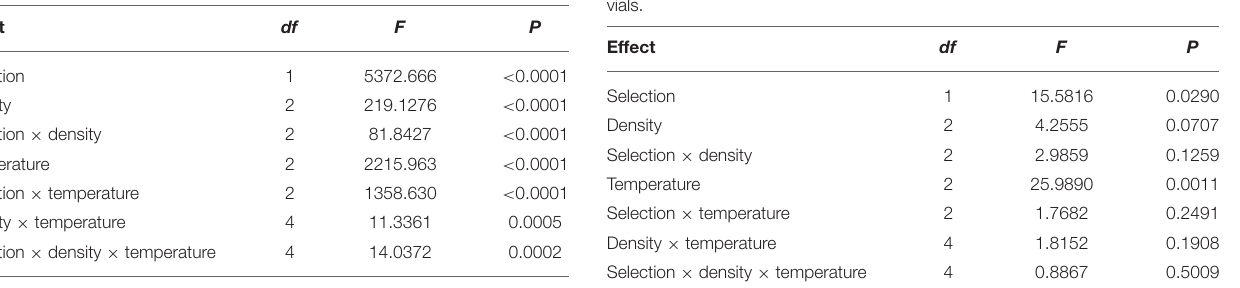
TABLE 1 | Results of ANOVA on mean development time. TABLE 2 | Results of ANOVA on standard deviation of development time across